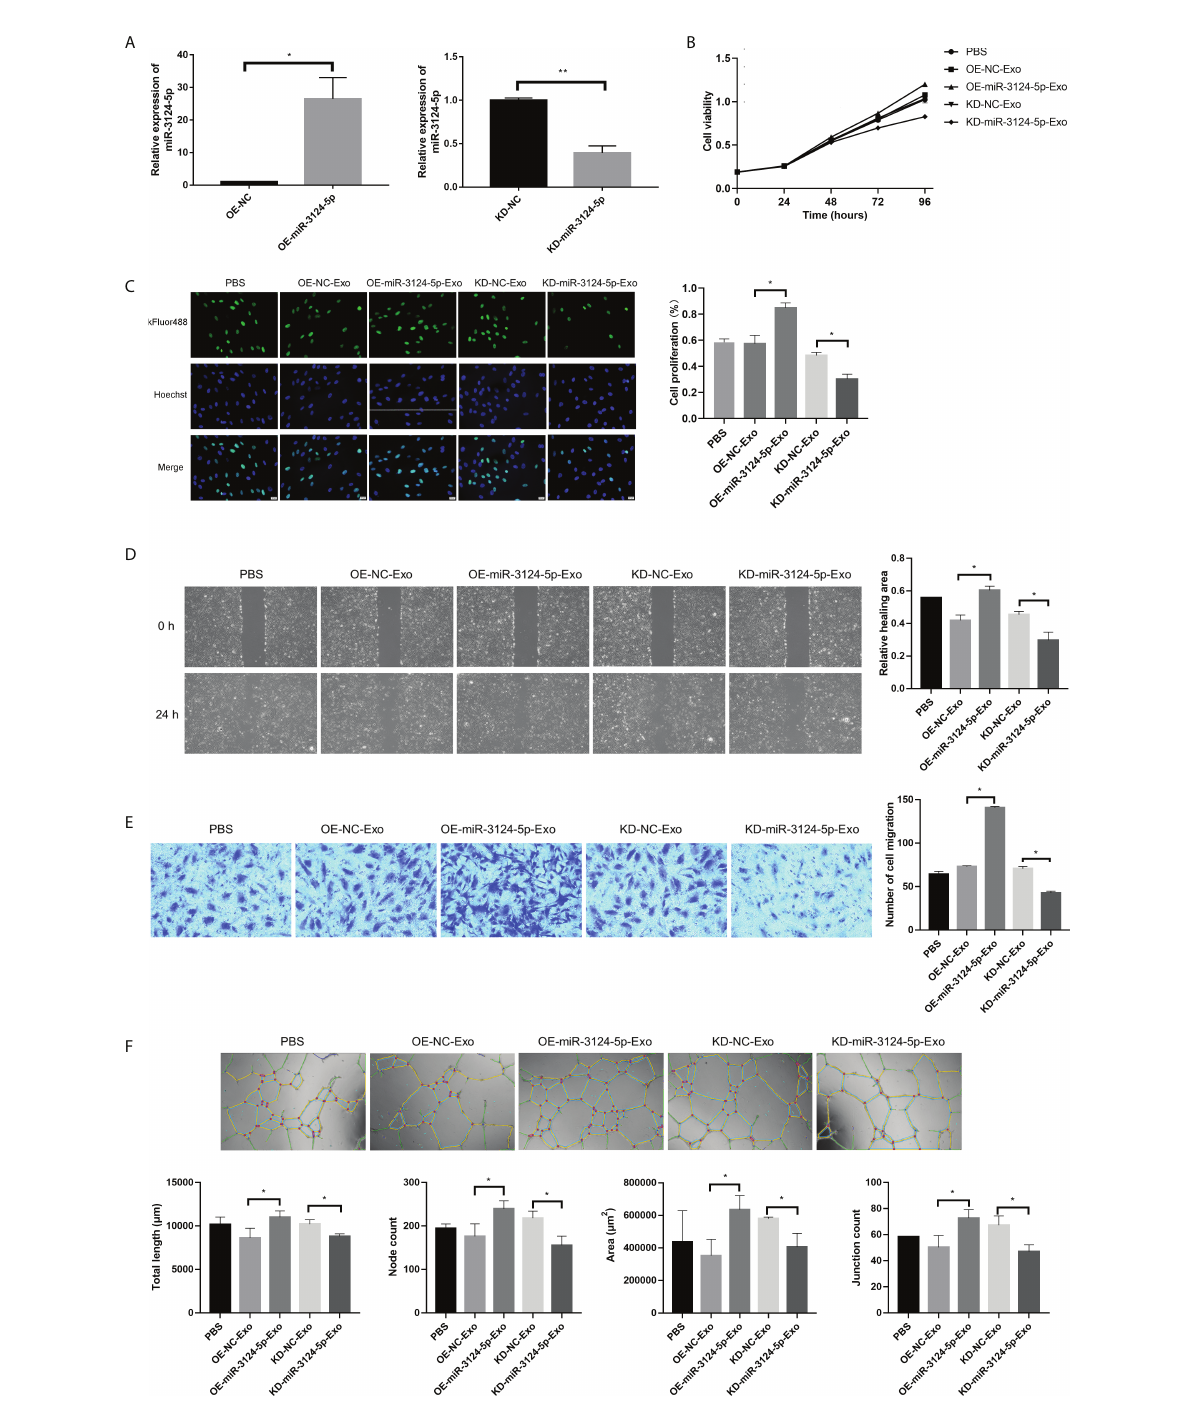
FIGURE 5 The effects of exosomes from RBE cells with aberrant miR-3124-5p expression on the proliferation, migration, and angiogenesis of endothelial cells. HUVECs were co-cultured with the exosomes in different treatment groups (PBS, OE-NC-Exo, OE-miR-3124-5p-Exo, KD-NC-Exo, and KD-miR-3124-5p-Exo). (A) qPCR showed the expression of miR-3124-5p in RBE cells after transfection. (B) CCK-8 assay showed cell viability of HUVECs in different treatment groups. (C) EdU assay showed HUVEC proliferation in different treatment groups. (D) Scratch wound healing assay showed the healing abilities of HUVECs in different treatment groups. (E) Transwell migration assays indicated HUVEC migration in different treatment groups. (F) Tube formation assay revealed the total length, node count, area, and junction count of HUVECs in different treatment groups. * p < 0.05. and ** p <